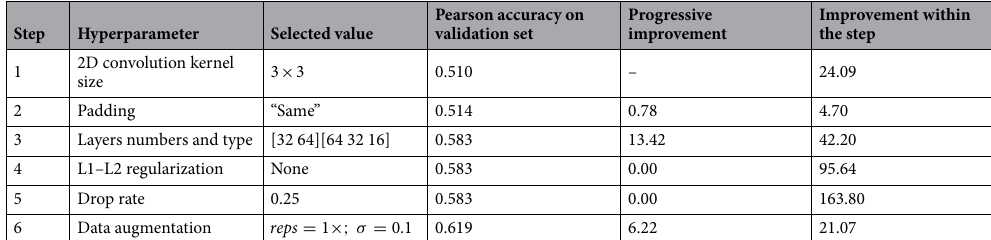
Table 2. Successive model-building steps. The starting network was a three-layer network. Each table row represents the optimization of a single hyperparameter, with the selected value and the obtained accuracy on the validation set. The last two columns report the percentage improvement in model performance (measured as Pearson accuracy) relative to the previous step or within each step (best vs. worst performance) [ reps : data replicates for augmentation; σ : standard deviation of the Gaussian noise introduced in the data].